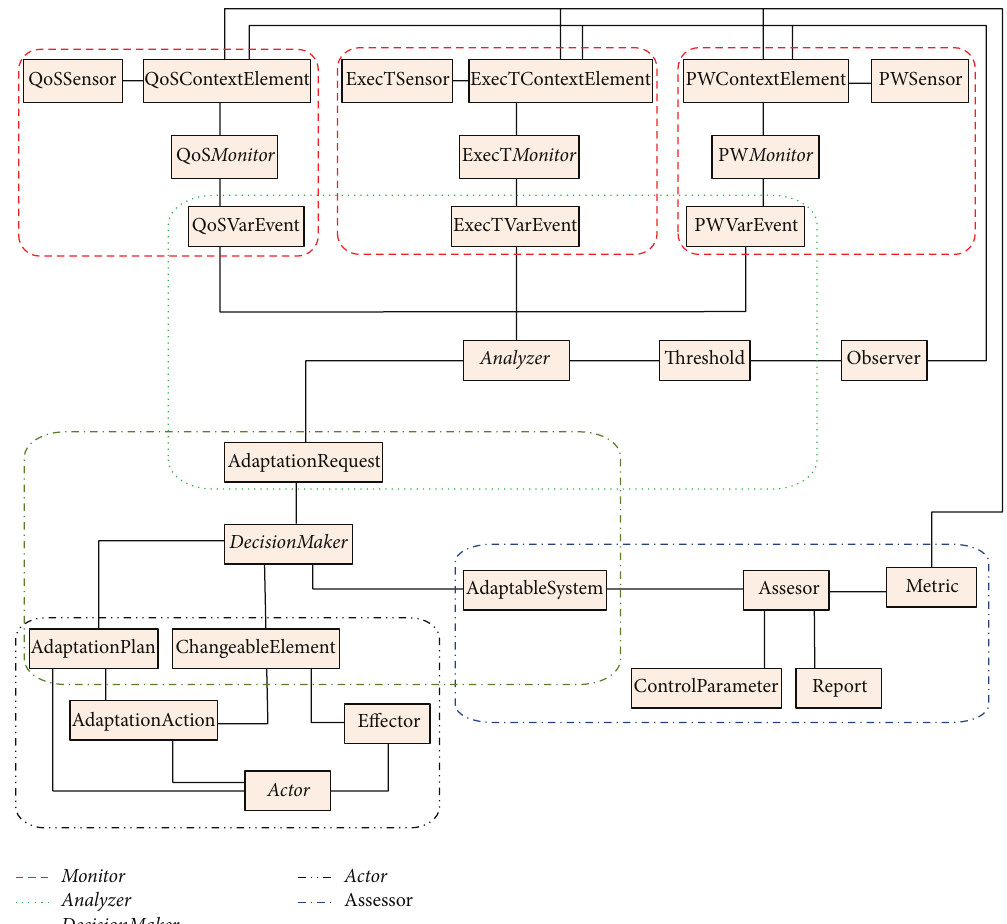
Figure 14: Patterns application to the closed-loop self-adaptive object tracking